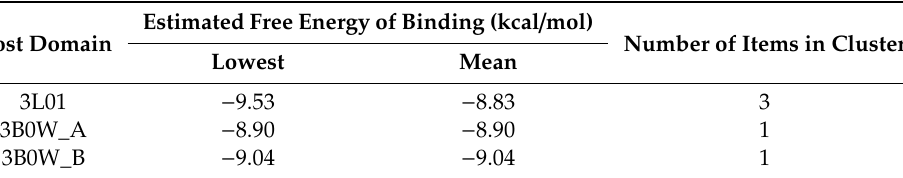
Table 1. The lowest and mean free energy of binding for each considered host domain.